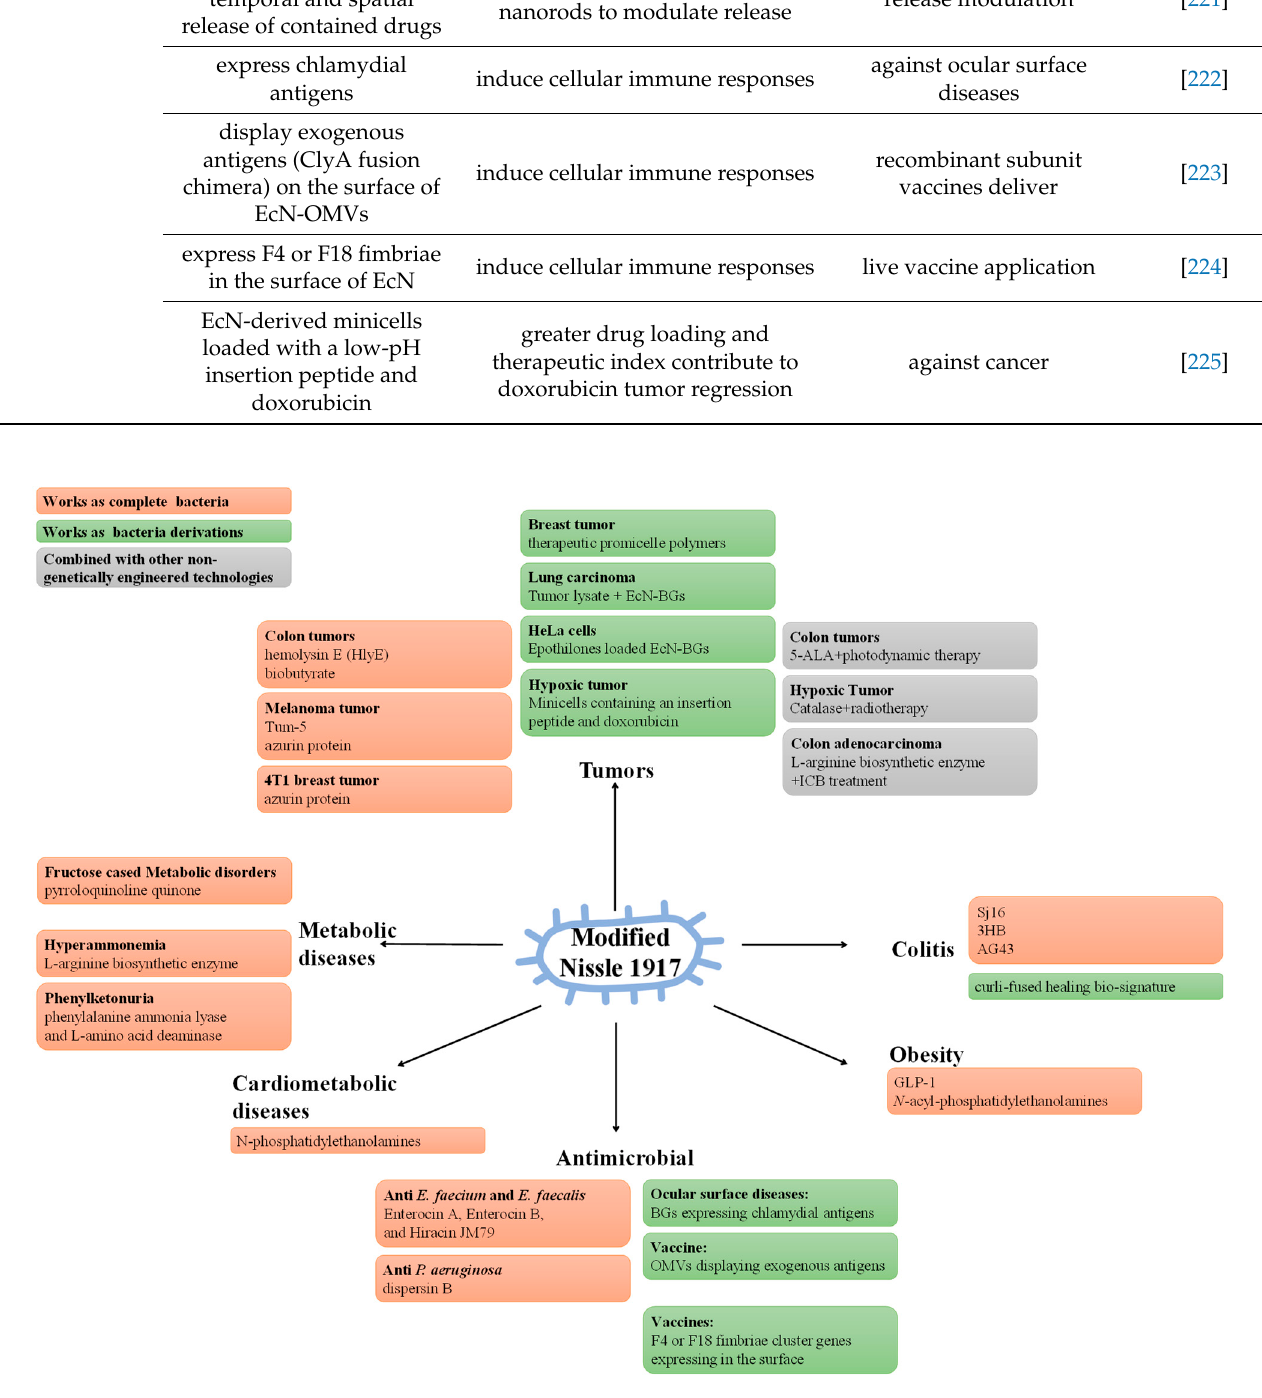
Figure 2. Strategies of modified EcN in diseases. There are three main strategies for modified EcN: 1. Expressing direct therapeutic factors. 2. Using the expressed therapeutic factors to complement other therapies. 3. Using EcN proper or its derivatives as carriers, relying on targeting or immune activity to transport the therapeutic factors. Table 1. The strategy of modified EcN in the treatment of diseases.